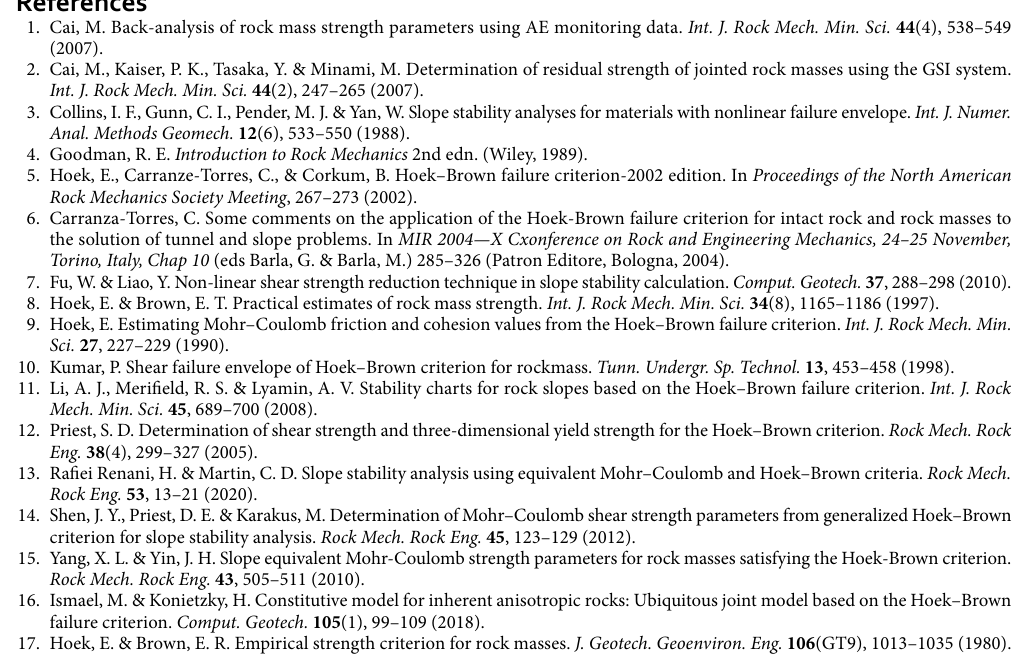
Figure 14. Comparison of the appropriate